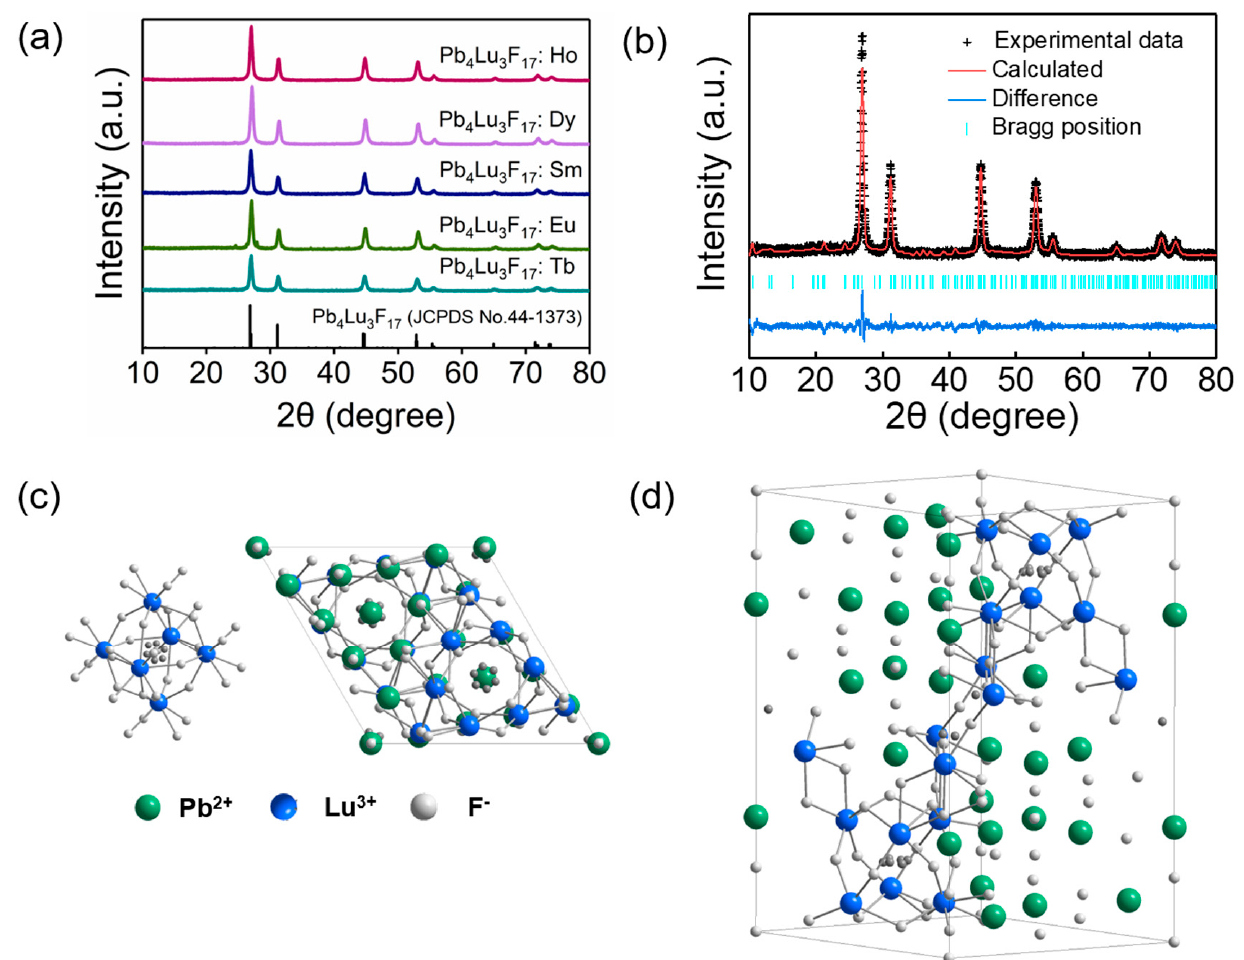
Figure 1. ( a ) XRD patterns of the Pb 4 Lu 3 F 17 : Re (Re = Tb, Eu, Sm, Dy, Ho) samples. ( b ) Experimental (black plus), calculated (red line) and difference (blue line) results of XRD refinement of Pb 4 Lu 3 F 17 : Tb. ( c ) A typical Lu 6 F 37 cluster, the crystal structure viewed in c-direction. ( d ) Crystal structure of the rhombohedral phase Pb 4 Lu 3 F 17 .